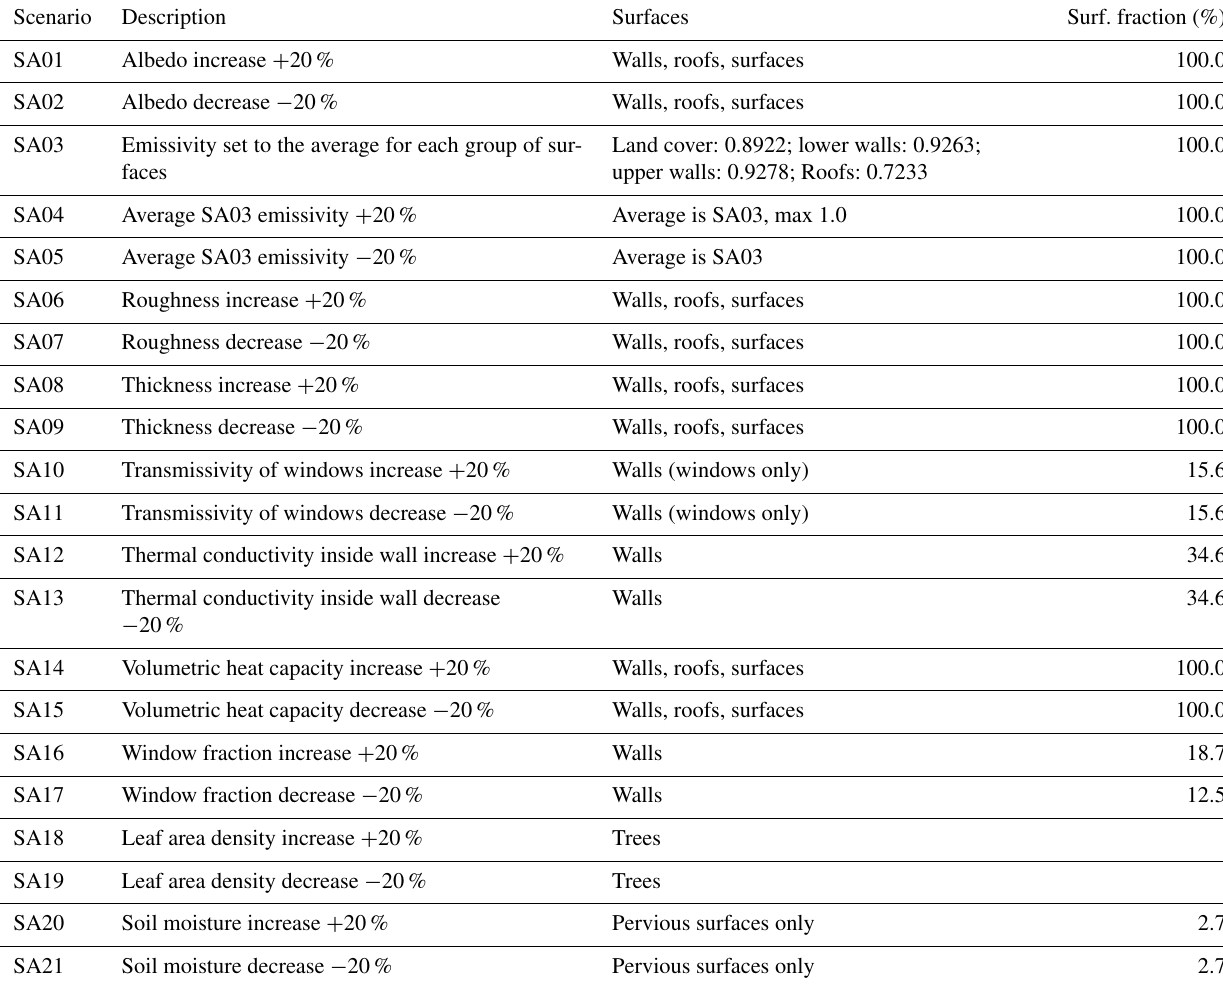
Table 1. Scenarios testing model sensitivity to changes in material parameters with fraction of affected domain surface area (column Surf. fraction). A detailed description of surfaces is in Sect.